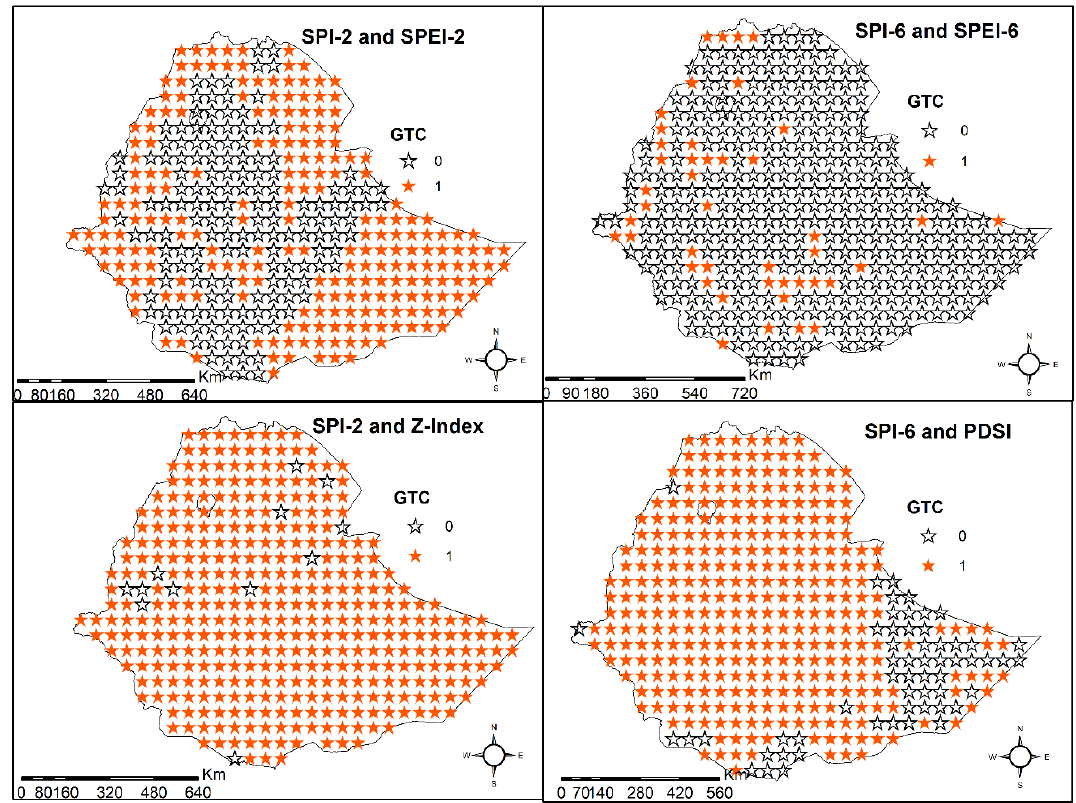
Figure 4. Spatial locations in Ethiopia where the Granger test rejected the null hypothesis of no correlation between meteorological and agricultural droughts (1-null hypothesis was rejected at 0.05 significance; 0-null hypothesis was not rejected or multicollinearity issues were found).